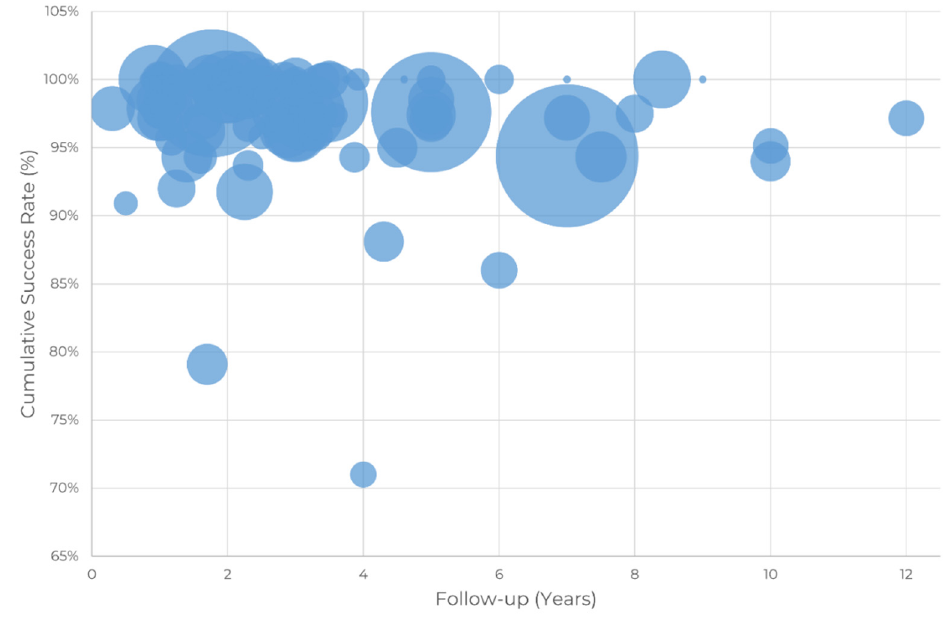
Figure 4. Cumulative success rate as a function of clinical follow-up. The size of the circle is proportional to the number of patients included in the study.